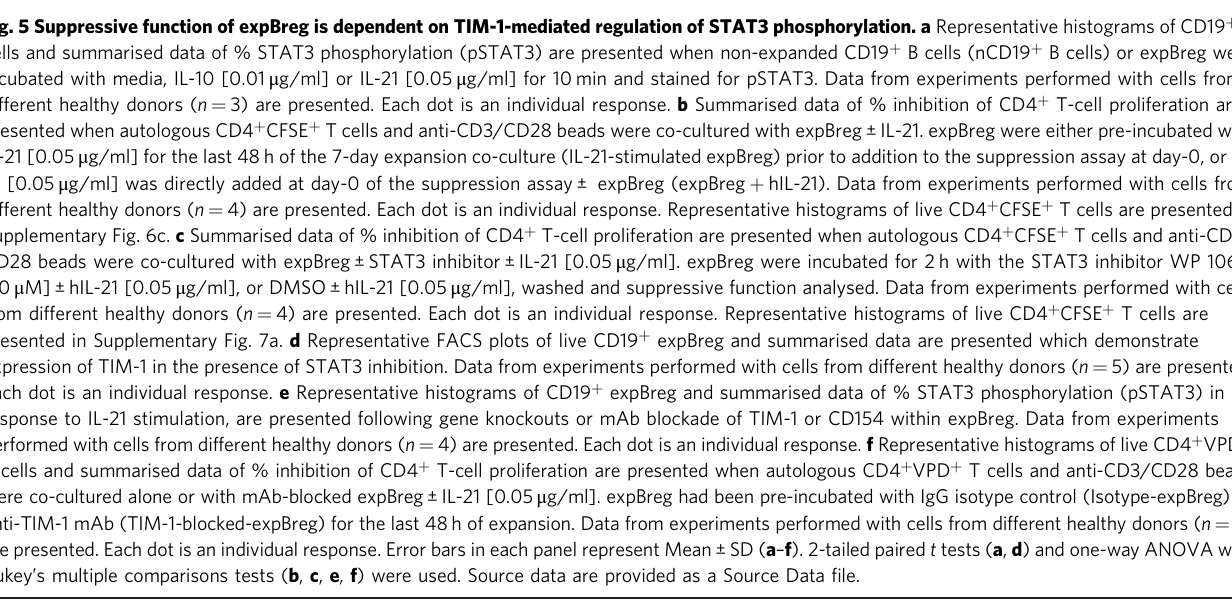
Fig. 5 Suppressive function of expBreg is dependent on TIM-1-mediated regulation of STAT3 phosphorylation. a Representative histograms of CD19 + B cells and summarised data of % STAT3 phosphorylation (pSTAT3) are presented when non-expanded CD19 + B cells (nCD19 + B cells) or expBreg